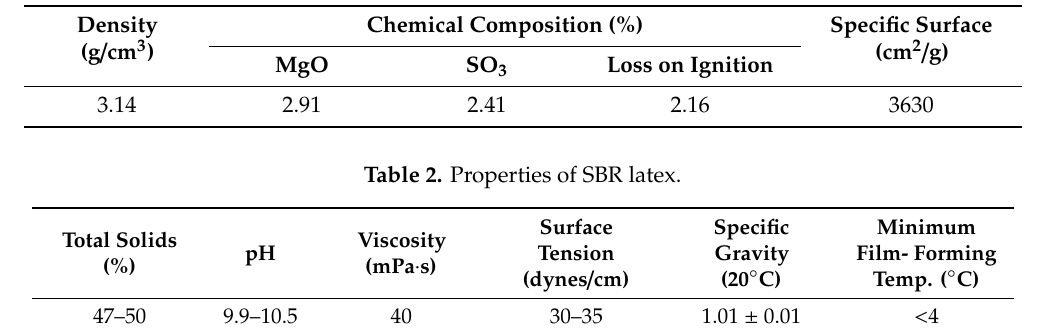
Table 1. Properties of ordinary Portland cement.